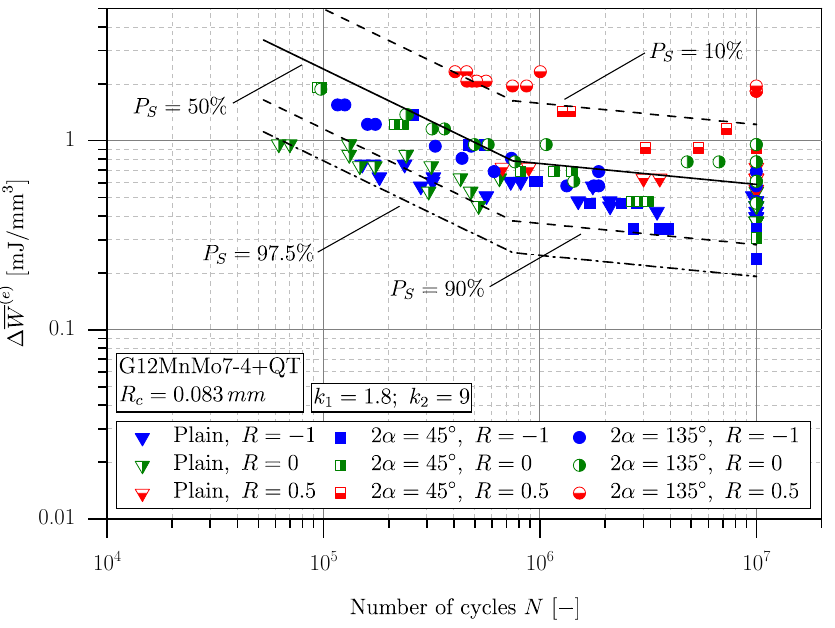
Figure 8. Linear-elastic strain energy density-based design limit curve.